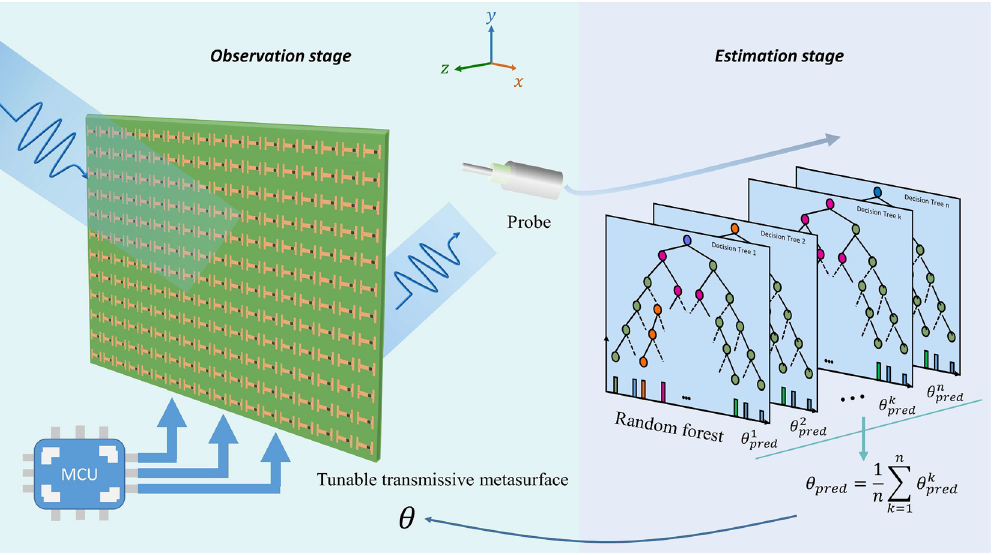
Figure 1: Schematic of machine-learning-enabled metasurface for DOA estimation. The metasurface-enabled DOA estimation method com- prises a tunable transmissive metasurface and one single receiving probe in observation stage and random forect (RF) for prediction in estimationstage.Thetunablemetasurface,configuredwithamicrocontrolunit,willswitchtospecificphasepatternsmultipletimestocontrol the transmissive waves, as received by a single probe located in a fixed place. The amplitude data, containing adequate directional information in each phase pattern, will be delivered to the RF in real